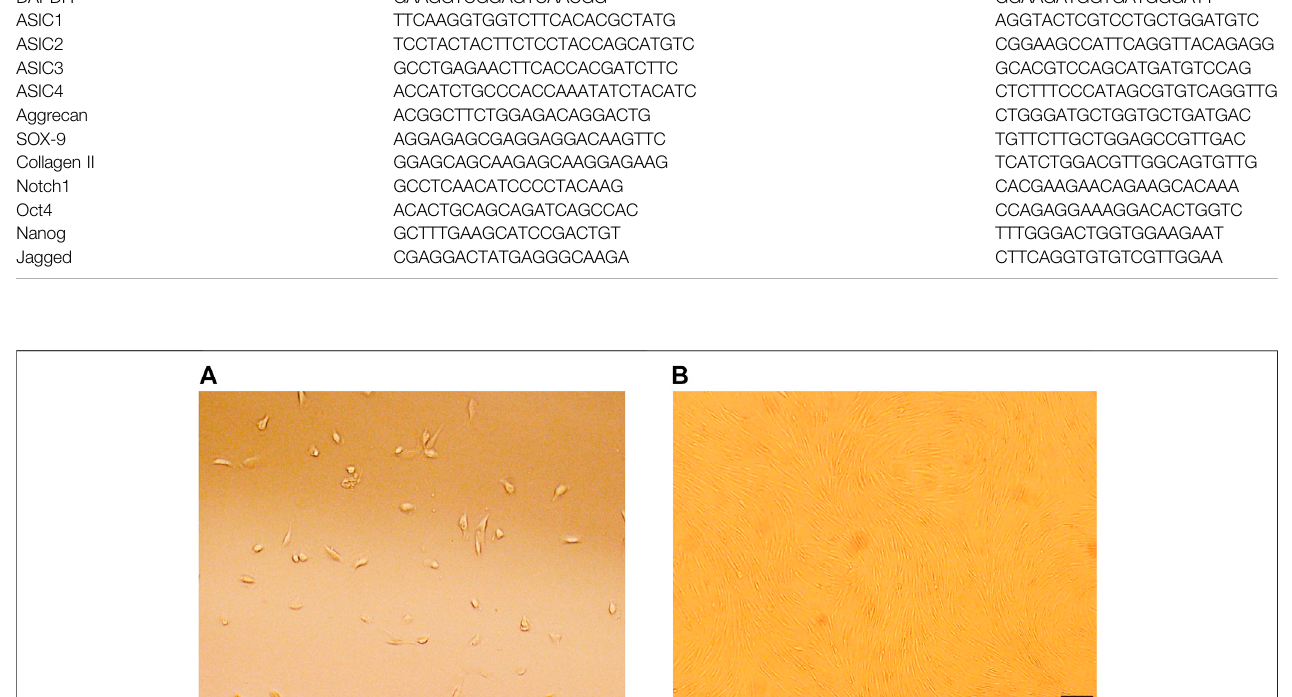
Frontiers in Bioengineering and Biotechnology |